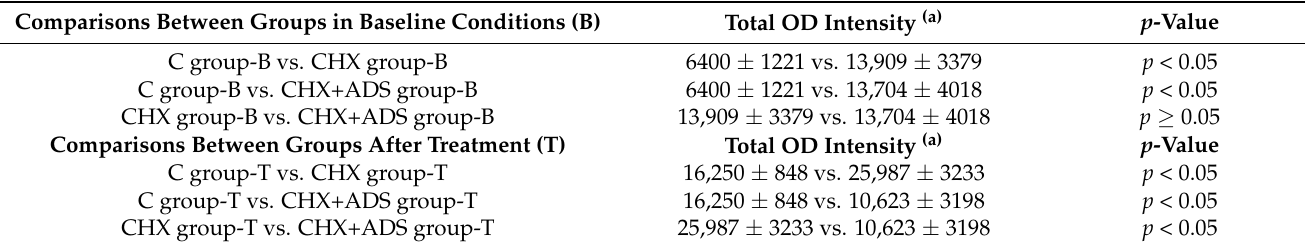
Table 2. Densitometric analysis of protein bands: a comparison between the groups at the same stage (basal or post-treatment).